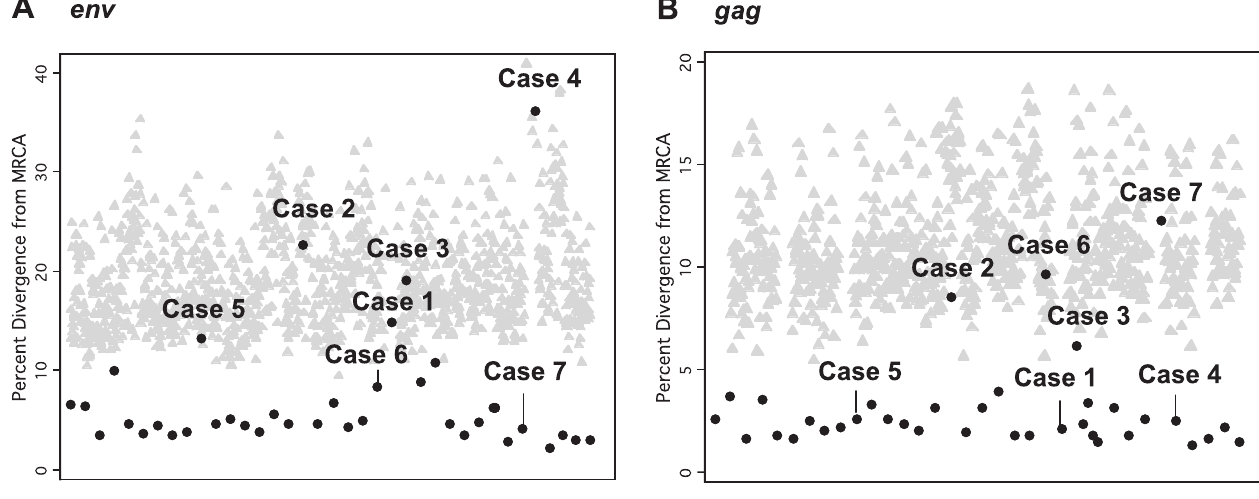
Figure 2. Maximum Divergence from the MRCA for Chronic env (A) and gag (B) Sequences Comparisons within individuals (black circles) and between subtype A–infected individuals (gray triangles) are arbitrarily distributed along the x -axis. Superinfection cases are labeled in both plots. For most cases, the high divergence indicative of superinfection is apparent in one region of the genome but not the other, consistent with Figure 1.